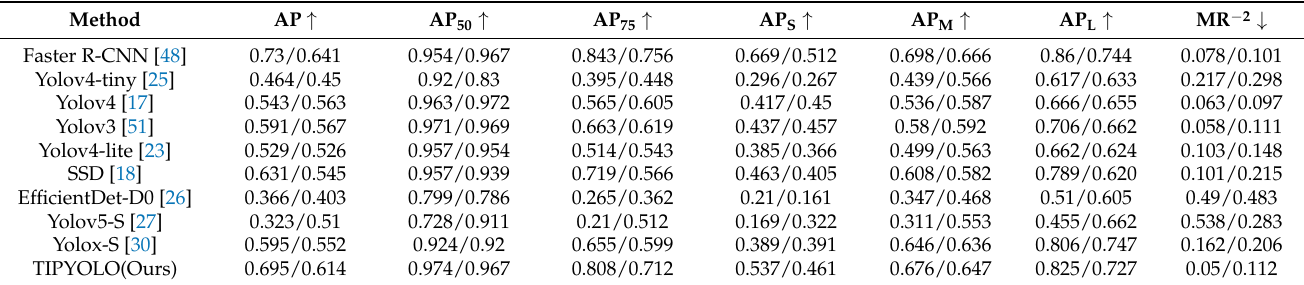
Table 5. The comparison results of the methods on KAIST and CVC-14 datasets. In columns 2 to 8, the values to the left of “/” represent the test result on the KAIST data, and the values to the right of “/” represent the test result on the CVC-14 dataset. “ ↑ ” indicates that the larger the value, the better the performance; “ ↓ ” indicates that the smaller the value, the better the performance.